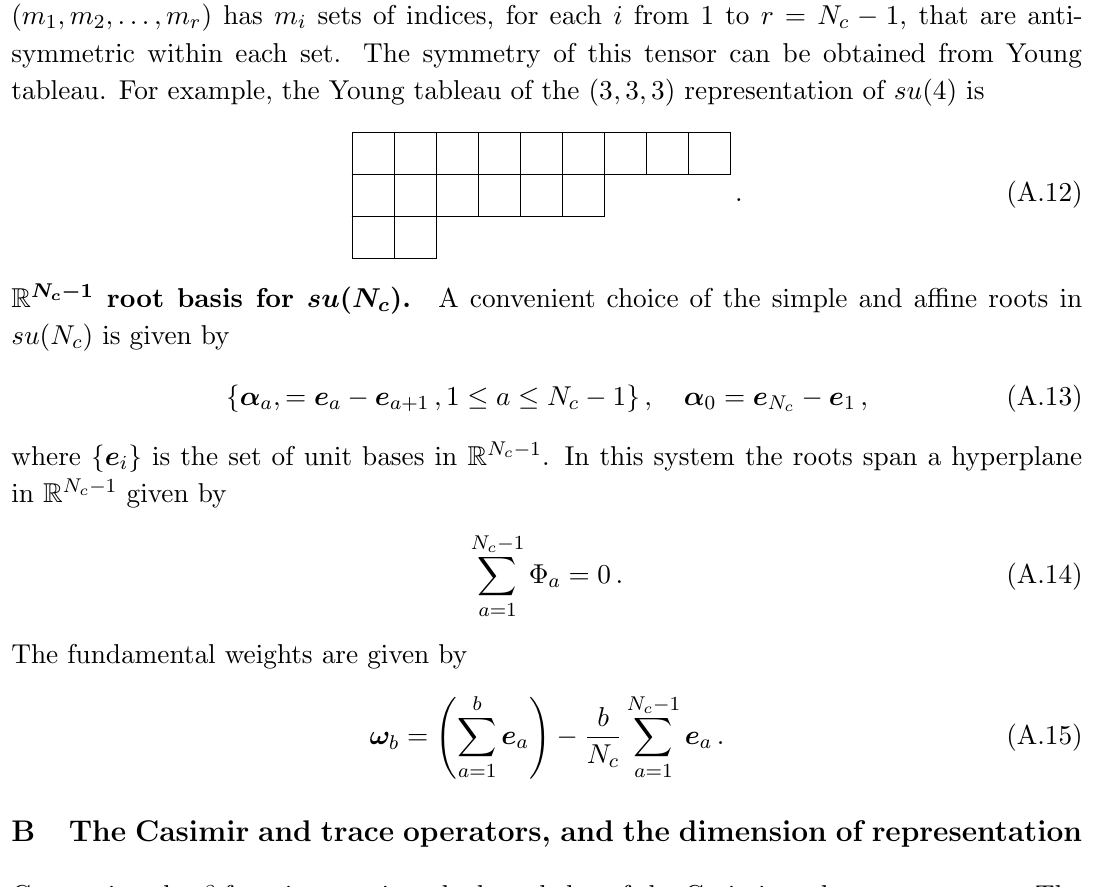
Table 9 . Examples of various representations and their Dynkin indices. Tensors and Young